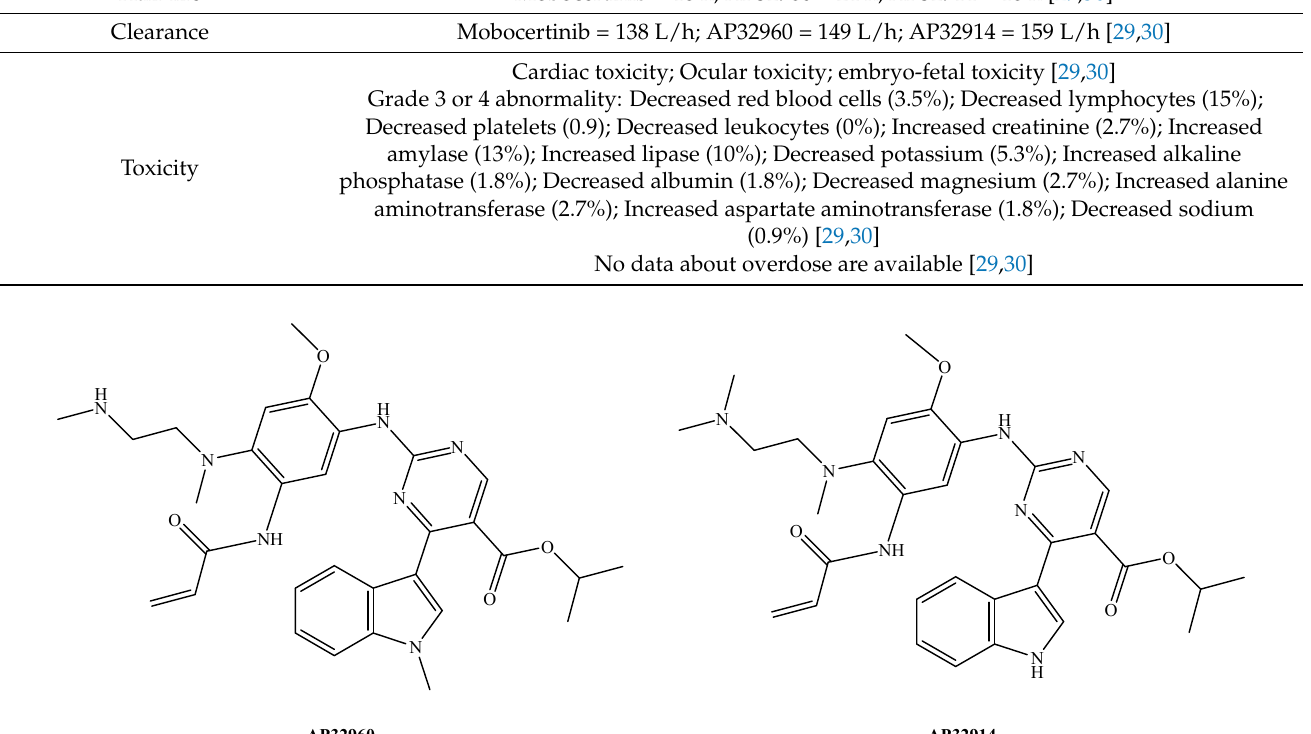
Figure 2. Chemical structures of N ‐ demethylated active metabolites of mobocertinib (AP32960 and AP32914).